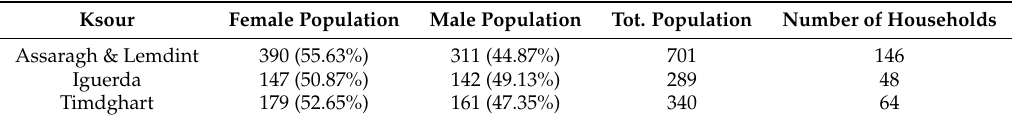
Table 9. Data from the census of 2014 (RGPH 2014 [64]). More details about the occupation structare are available in the Table A1.